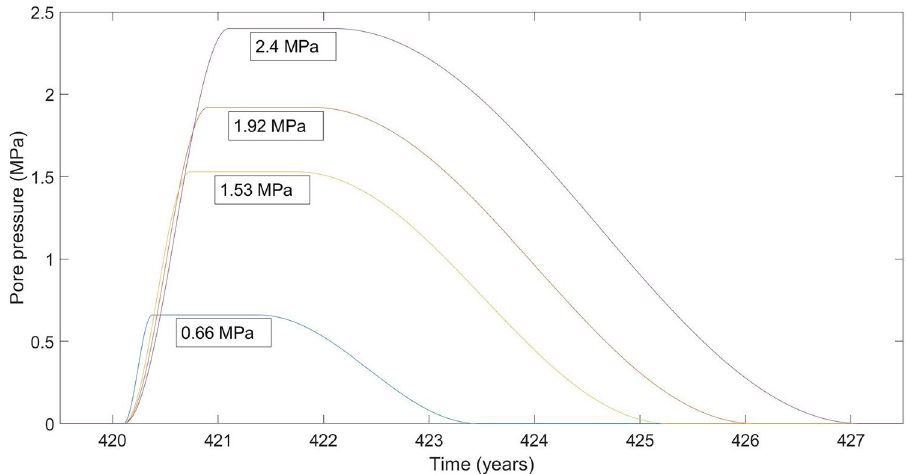
Figure 6. Pore pressure versus time based on Eq. 5. The average rate of increase ( p m − p 0 / t e − t s ) is the same in all these cases, although the instantaneous rate of increase depends on the value of the cosine function being used. In all these cases injection stops one year after the pore pressure reaches